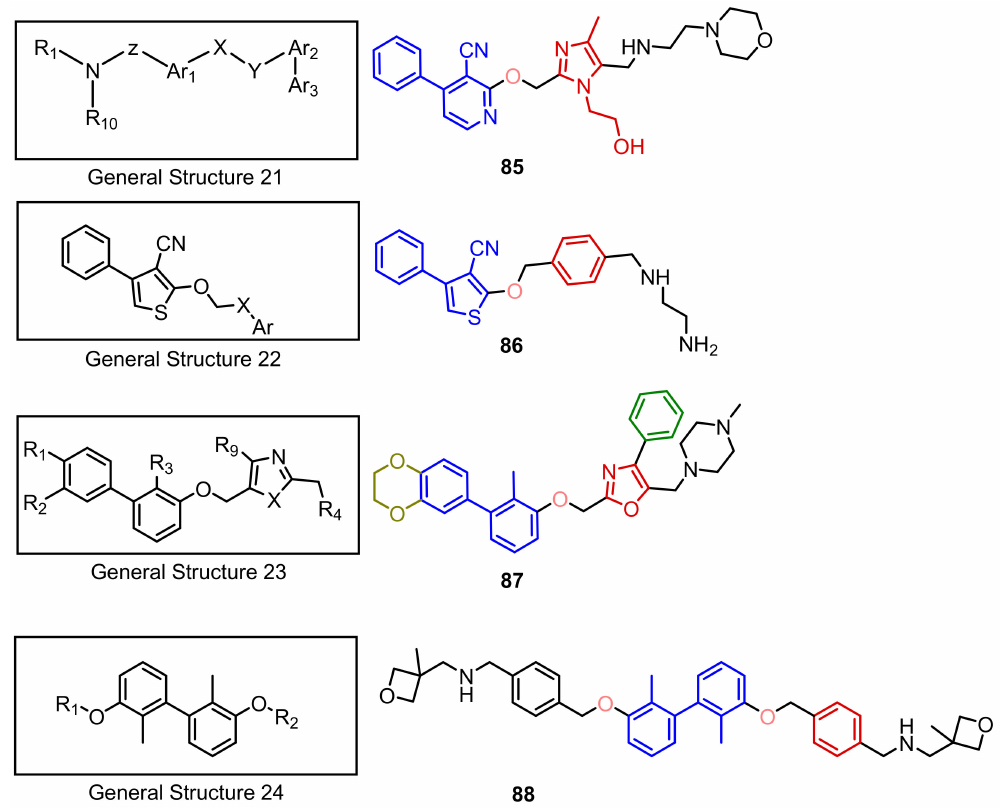
Figure 35. General structures 21–24 and examples of compounds 85 – 88 described by